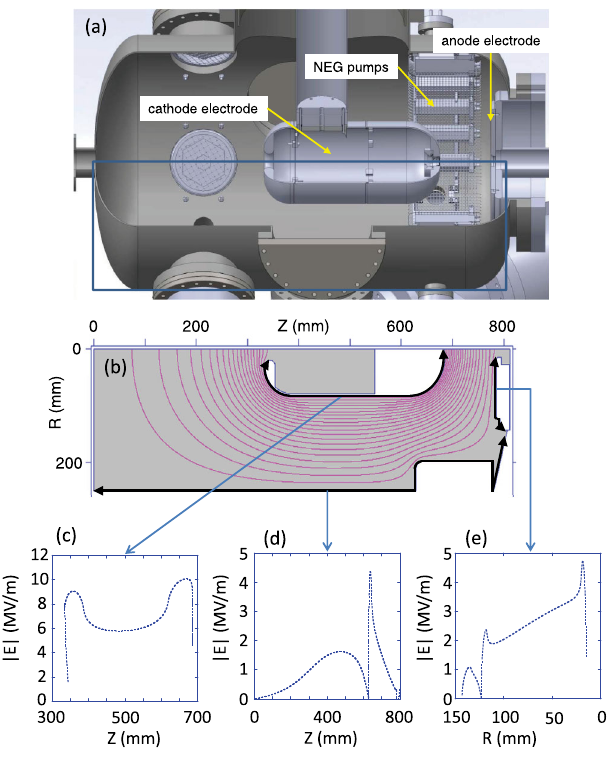
FIG. 3. (a) Cutaway drawing of gun chamber configuration (A) and (b) radial cross section showing static electric field calcu- lation for the gun chamber. Surface electric field distributions at 500 kV (c) of the cathode as a function of Z , (d) of the HV chamber as a function of Z , and (e) of the anode electrode as a function of R . wiped the cathode electrode with a lint-free tissue, taking care to minimize the air exposure of the gun chamber.